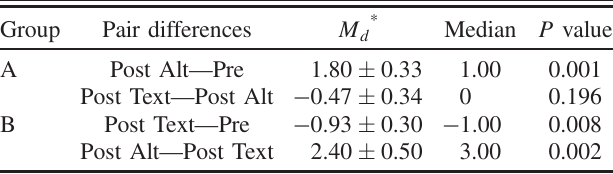
TABLE IV. Gain scores on concept of pressure and displace- ment nodes and antinodes ( n ¼ 15 for each